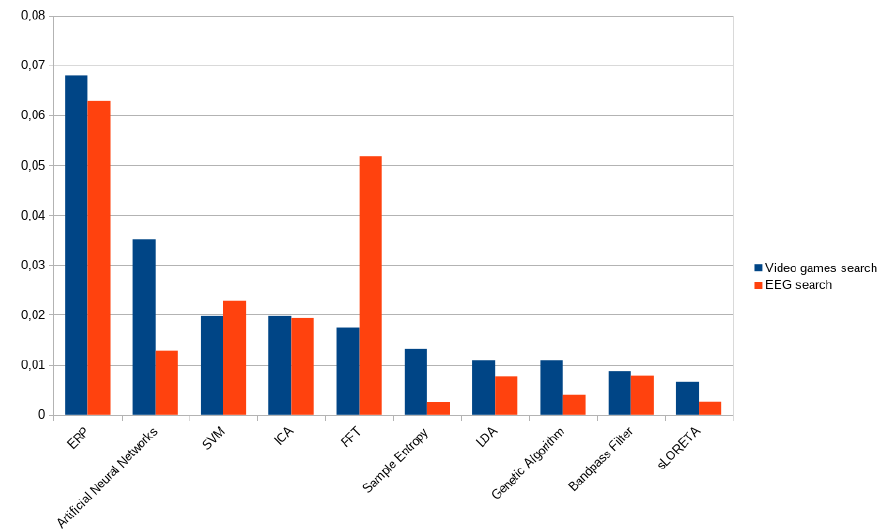
Figure 4. Ten most popular techniques when using EEG and video